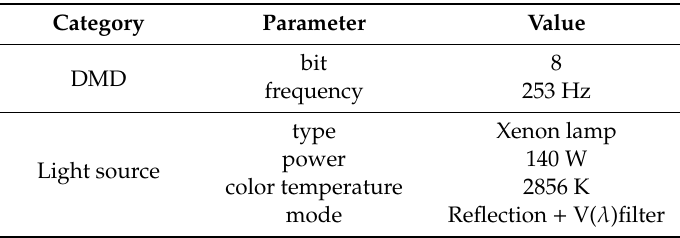
Table 2. Parameters of DGGE.